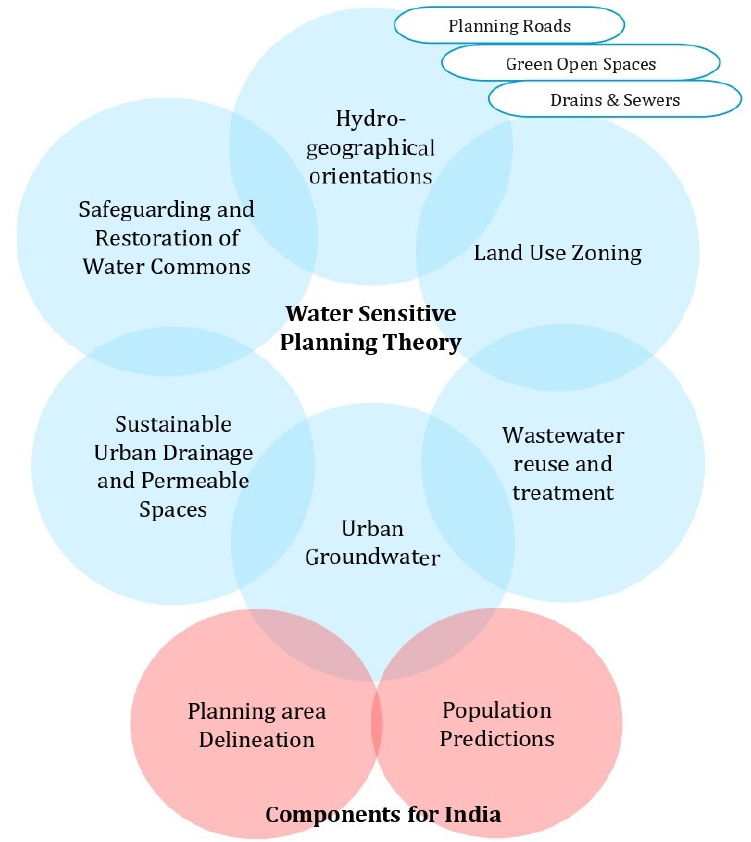
Figure 1. Substantive Components of Water Sensitive Planning for the Cities of Global South